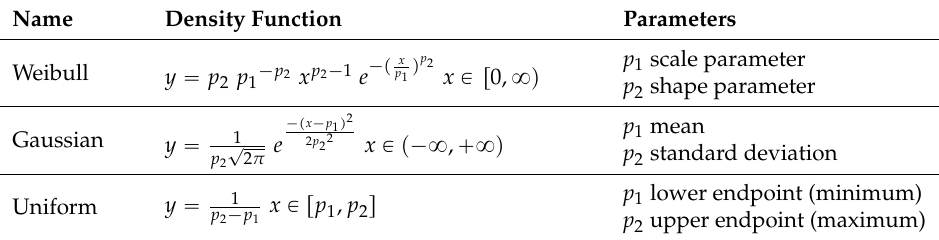
Table 1. Density functions of the distributions chosen for the